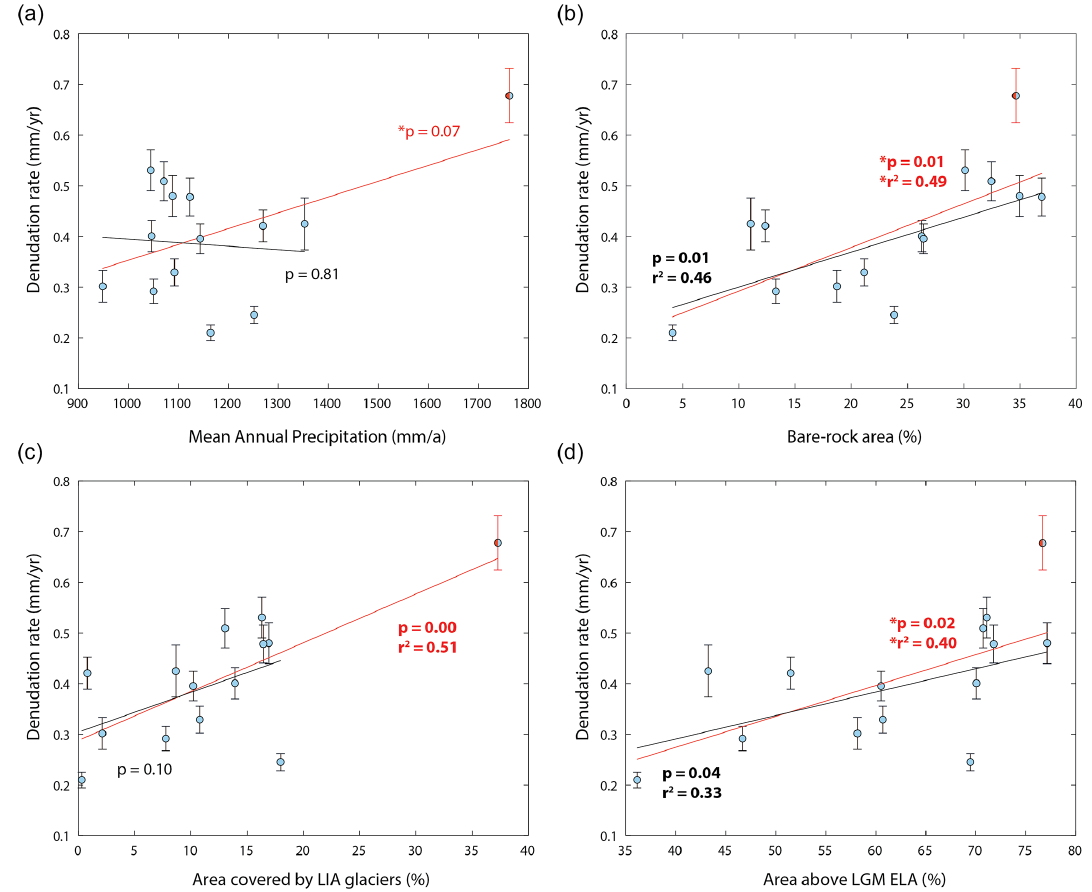
Figure 5. Relationships between tributary–catchment denudation rates and catchment (a) mean annual precipitation, (b) relative bare- bedrock area, (c) relative area covered by LIA glaciers and (d) relative area above LGM ELA (2103ma.s.l.). Correlations have been calculated including or not sample DB01 (red and black lines, respectively; see text for discussion). Correlation coefficients ( p value and r 2 ) are reported for each linear regression with statistical significance ( p value < 0 . 05). r 2 is not reported for non-significant correlations ( p value > 0 . 05). Asterisks indicate linear correlations for which DB01 has been considered as an outlier (based on Cook’s distance, Ta- ble